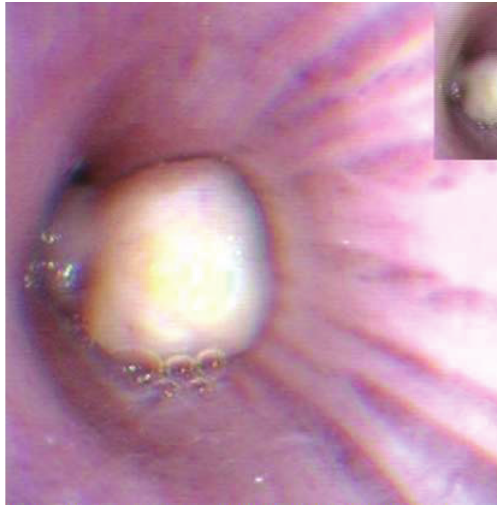
Figure 8: Endoscopy showed smooth yellow mass in the bronchial lumen of right inferior